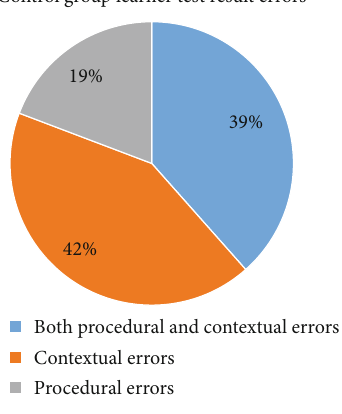
Figure 16: Control group test result errors.